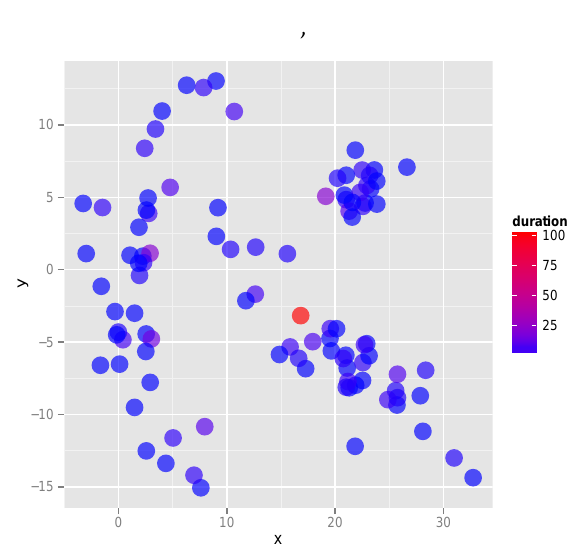
Figure 4. Duration of exemplars increasing the scale factor: The Figure 1 dataset has 100 objects ( n = 100 ). The scale factor increases from 1 (black) to 100 (red). When the scale factor is equal to 1, all the objects are exemplars. When the scale factor increases, some exemplars disappear. Only the standard is always extracted when increasing scale factor. Then its duration is equal to